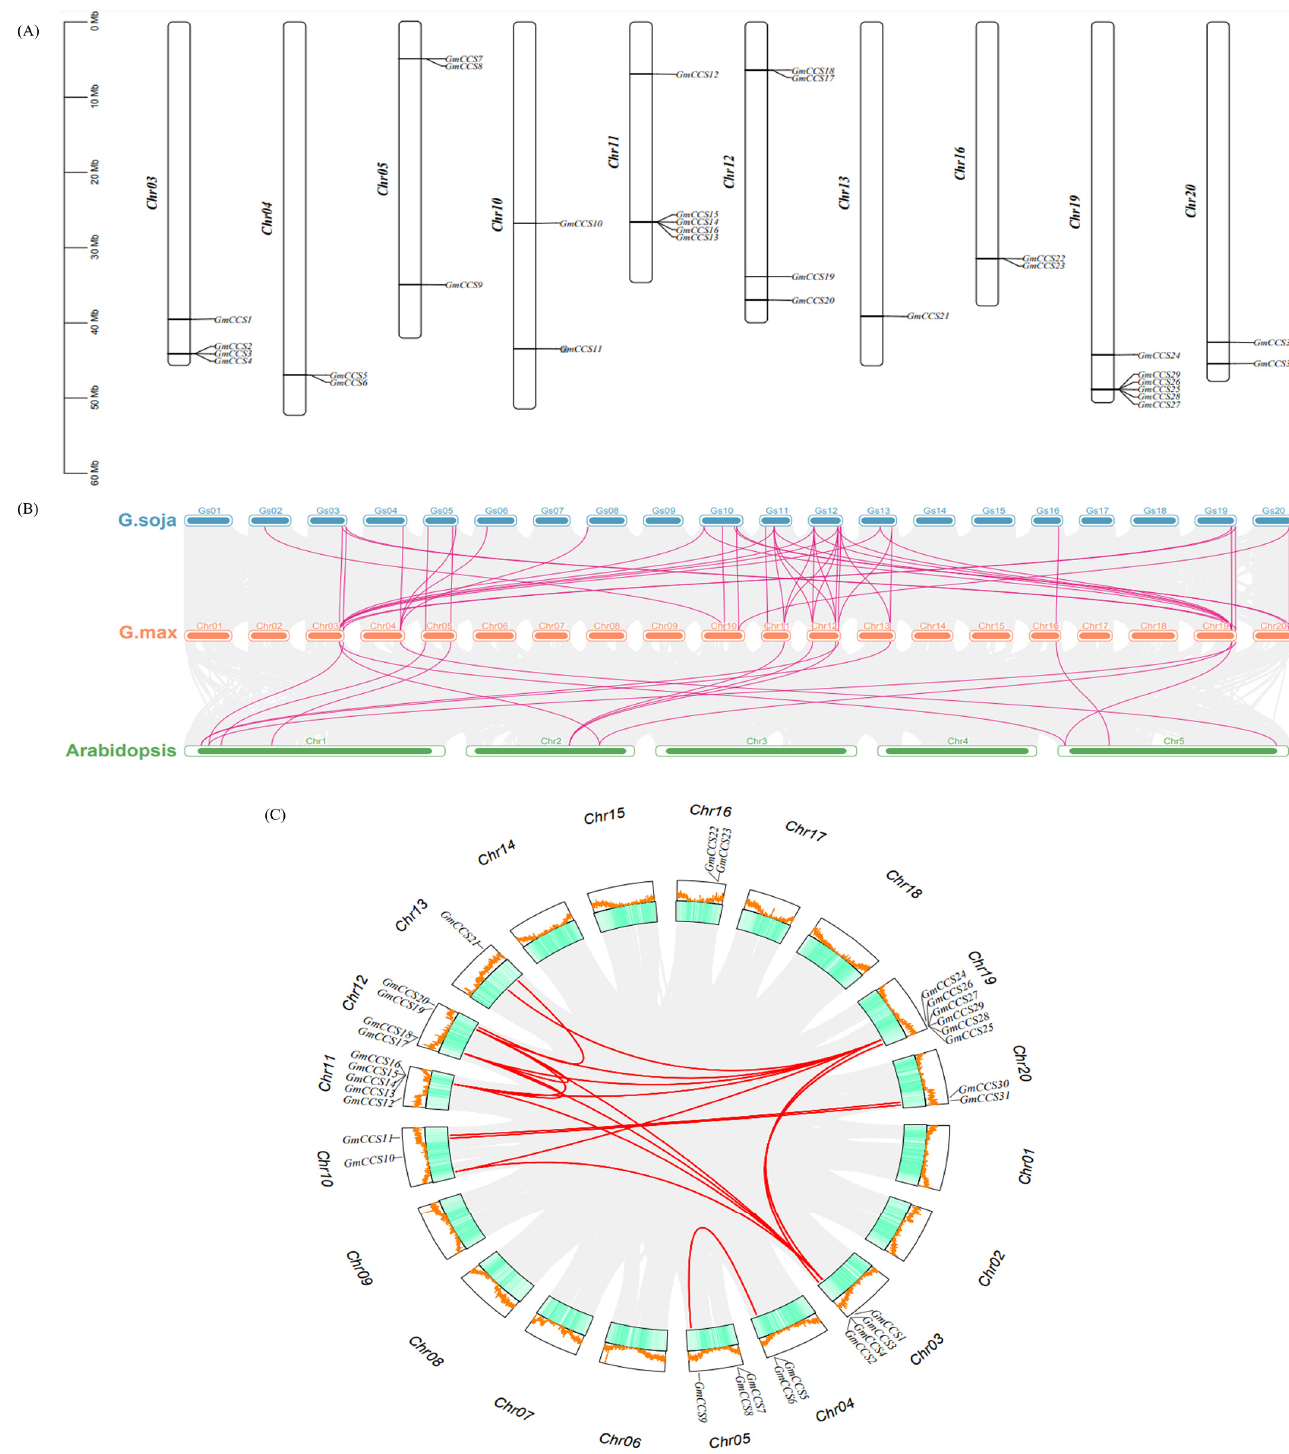
Figure 1. Chromosomal analysis of GmCCS members. ( A ) Chromosomal location of GmCCSs gene family in Glycine (G.) max . ( B ) Collinear analysis of GmCCSs with Arabidopsis and Glycine (G.) soja . Green, orange and blue represents Arabidopsis , Glycine (G.) max and Glycine (G.) soja , respectively. The bright lines indicate the connection with GmCCSs . ( C ) Chromosomal locations of GmCCS genes on 20 chromosomes of Glycine (G.) max and synteny analysis of interchromosomal relationships of GmCCS genes. The green blocks indicate parts of the radish chromosomes. The red lines indicate segment duplicated GmCCS gene pairs.